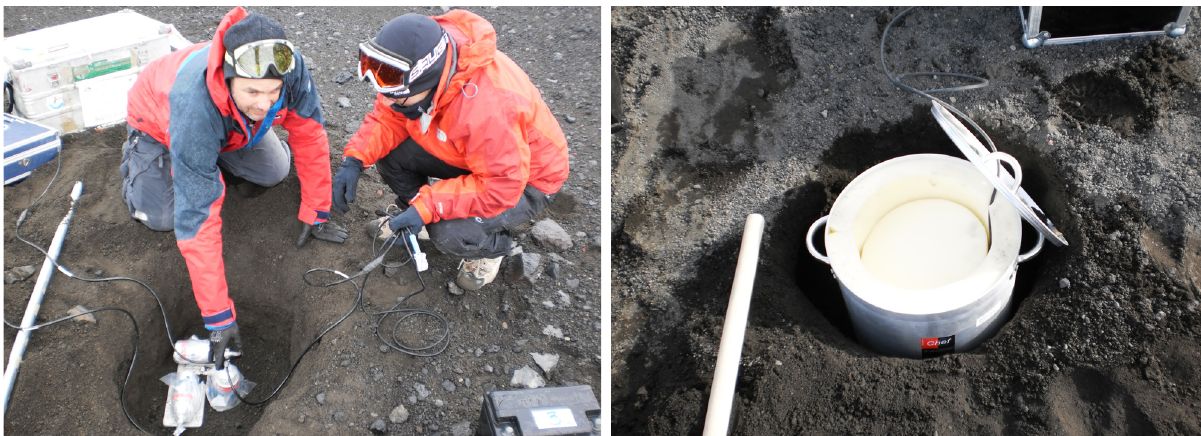
Figure 7. Left: installation of a three-component Mark Products L4C seismometer; right: installation of a three-component Lennartz 3D/5s seismometer.